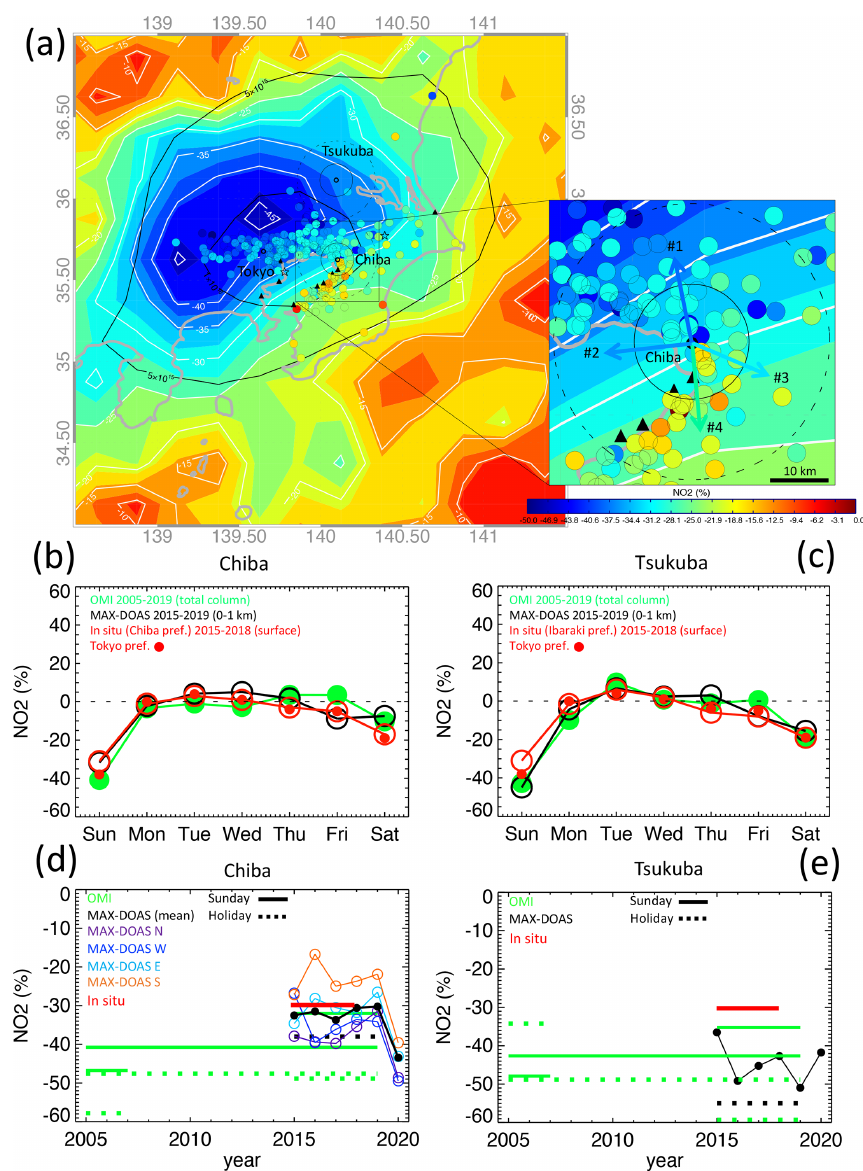
Figure 6. Spatial distribution of the weekend effect (Sunday minus weekdays) based on OMI NO 2 total tropospheric column (filled contours), MAX-DOAS partial tropospheric column ( < 1km, colored arrows), and in situ NO 2 observations (circles) over 2015–2018 ( a , main panel). Magnified view of the area around Chiba University (inset). NO 2 weekly cycle at Chiba and Tsukuba for the datasets noted above. In situ data were averaged across the prefecture (b, c) . The weekend effect (on Sunday) and the holiday effect (at the end of the year) were averaged over different periods (as indicated by the horizontal lines) at Chiba and Tsukuba (d, e) . MAX-DOAS NO 2 data are also plotted for each year and for each instrument at